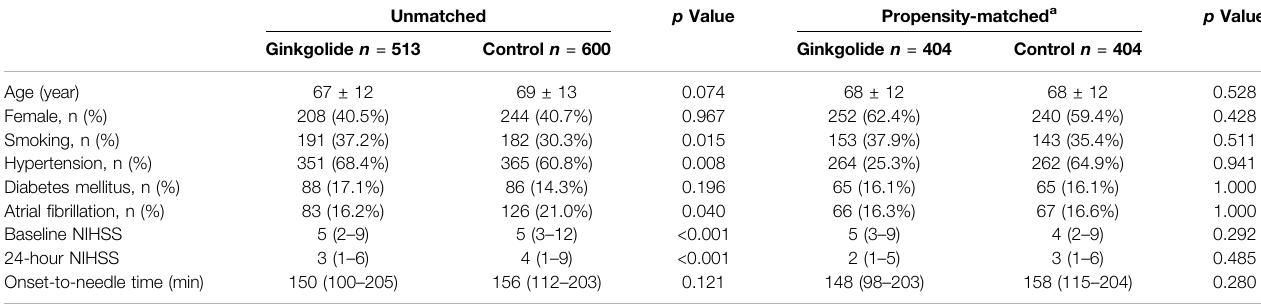
TABLE 1 | Univariate comparison of characteristics strati fi ed by intervention in unmatched and propensity-matched patients. Unmatched p Value Propensity-matched a